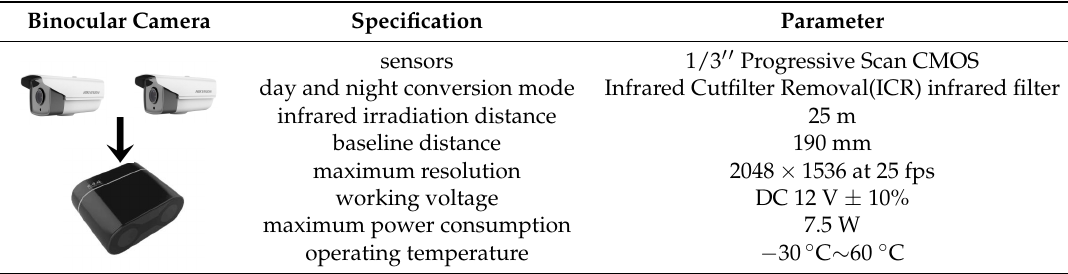
Table 1. The binocular camera